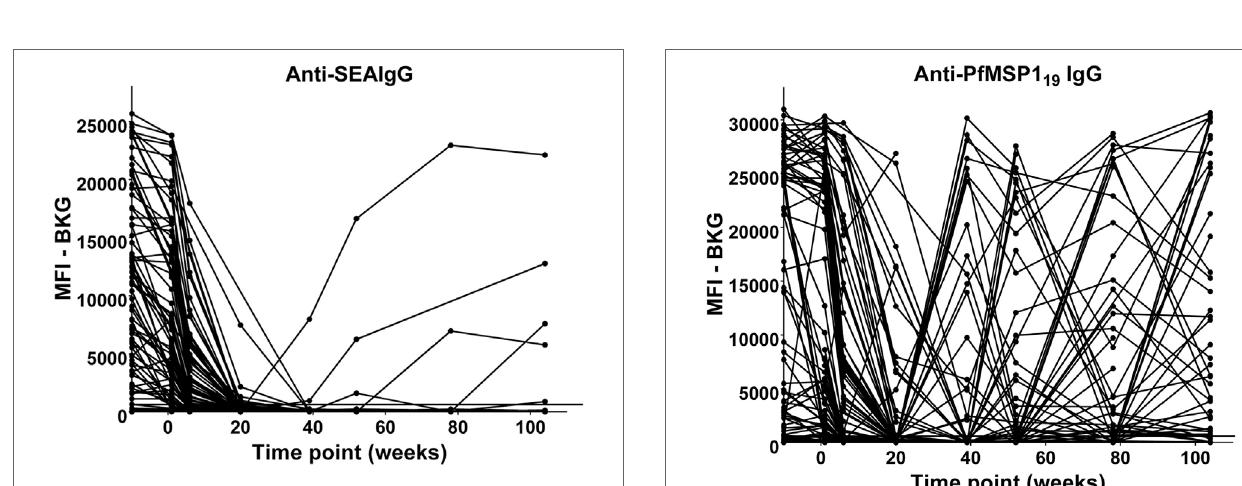
FigUre 6 | Time course of IgG antibody responses to PfMSP1 19 among infants from birth to 2 years. x -Axis shows time of sample collection, calculated from birth in weeks. Maternal antibody response is shown at − 10 weeks. Neonatal first bleed is shown at 1 week and subsequent bleeds are at 6 weeks and 5, 9, 12, 18, and 24 months. MFI, median fluorescence intensity; BKG, background. Horizontal line shows optimal cutoff (547) for positive antibody responses to PfMSP1 19 .